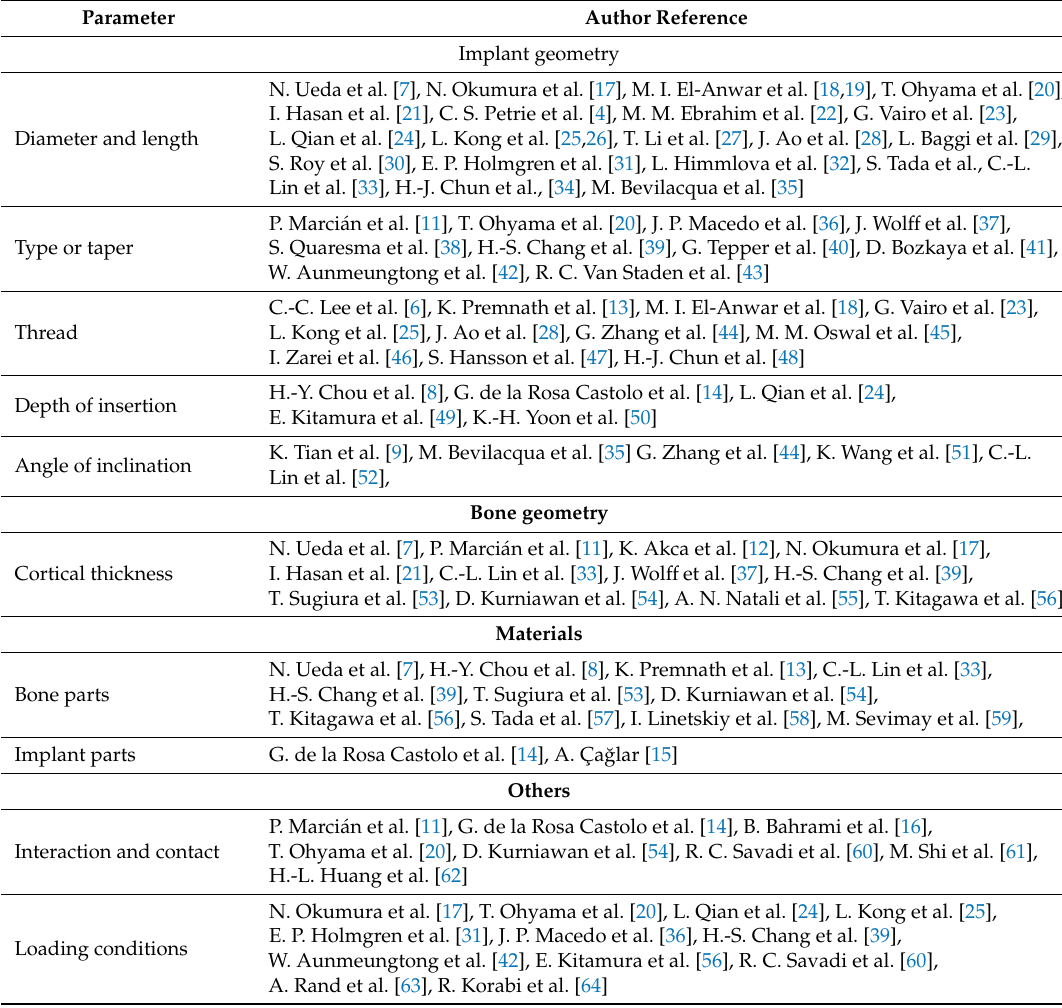
Table 1. Summary of the